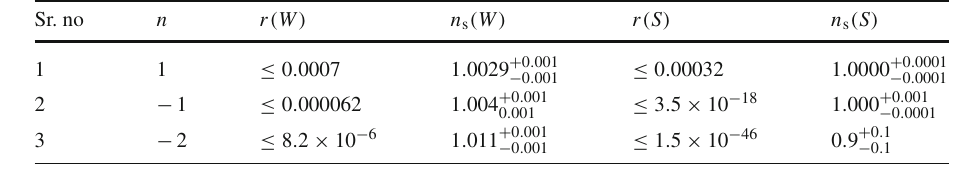
Table 7 GCCG weak and strong dissipative regime with negative quadratic and quartic potential